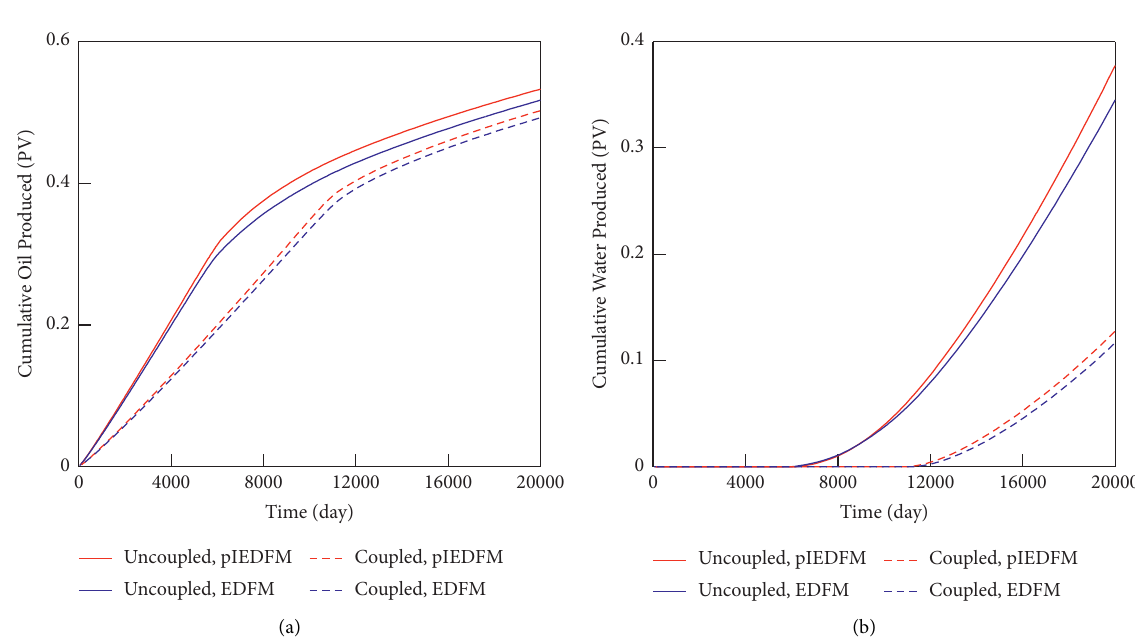
Figure 25: Cumulative (a) oil and (b) water production